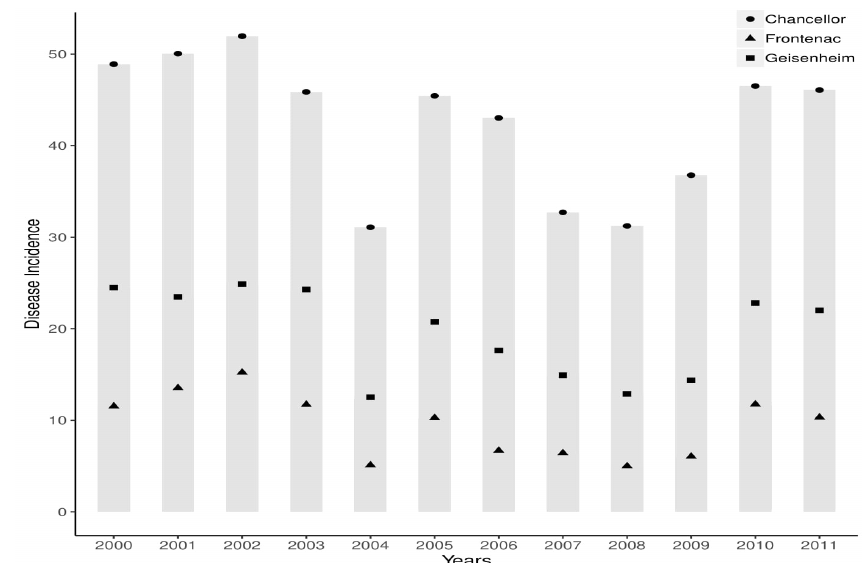
Figure 3. Annual first disease date (top) and the maximum DI (bottom) of grape PM for the three susceptible cultivars: Chancellor (circle); Geisenheim-318 (square); and Frontenac